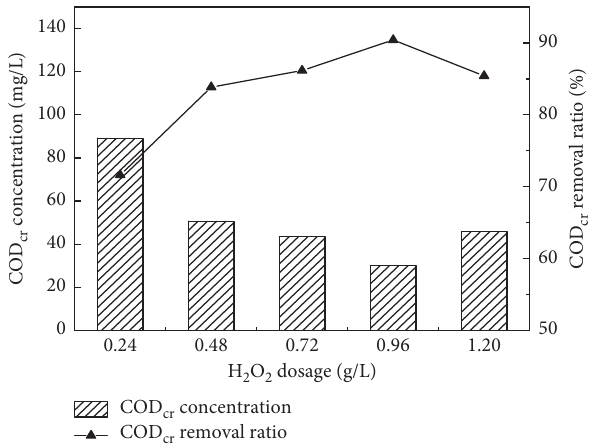
Figure 11: Effect of H 2 O 2 dosage on COD Cr